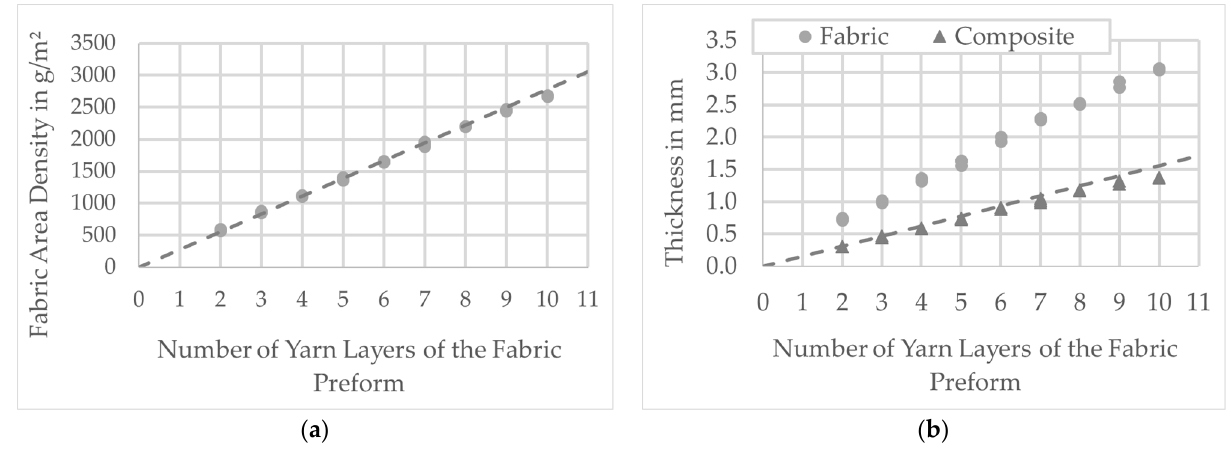
Figure 13. Results of the fabric testing for different number of yarn layers of the preform: ( a ) fabric area density and calculation result as trendline; ( b ) fabric and composite thickness and calculation result as the trendline.